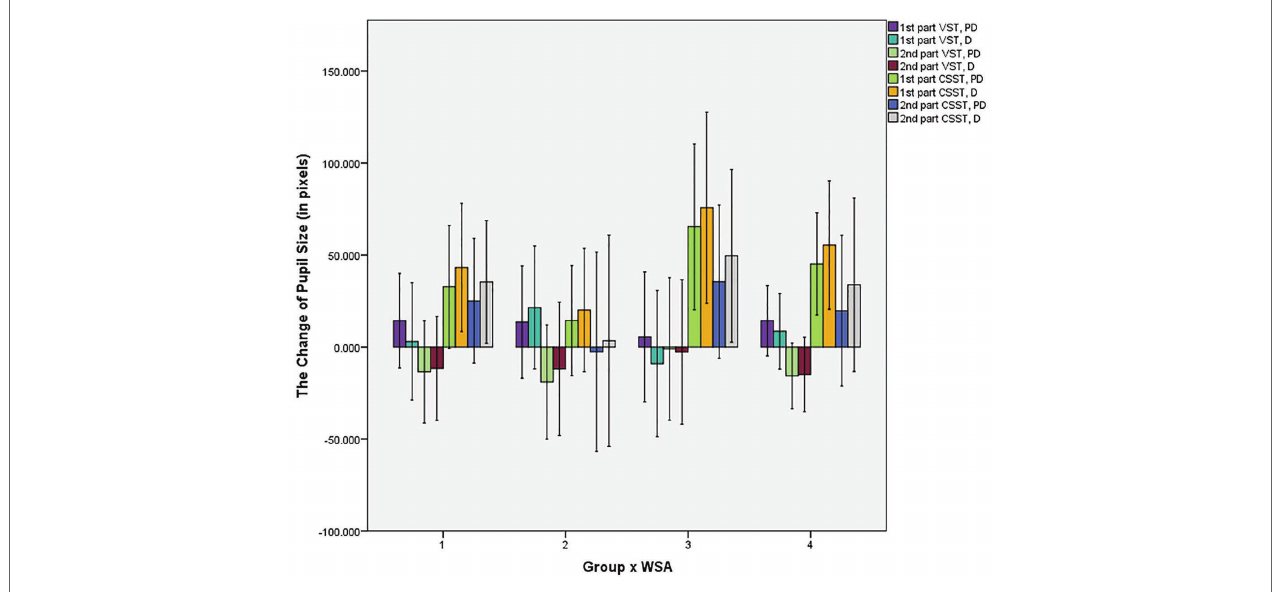
FIGURE 4 | Bar chart of differences of the change in pupil size (in pixels) in all conditions. PD, pre-distractor; D, distractor; Condition 1, PG with EP feedback; Condition 2, PG with ER feedback; Condition 3, RG with EP feedback; Condition 4, RG with ER